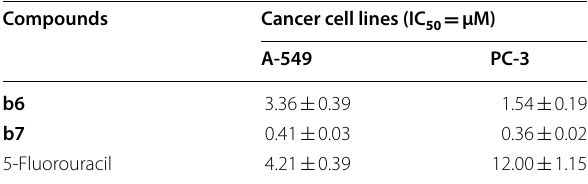
Table 20 Antitumor potential results of compounds